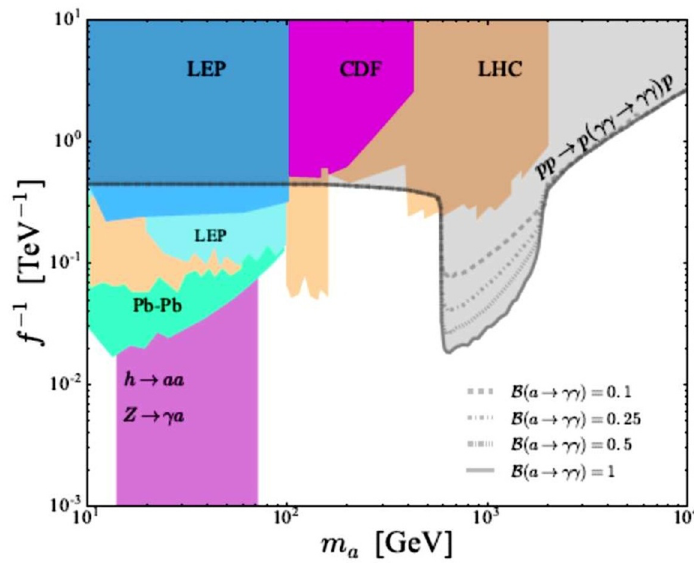
Figure 7 . The 95% C.L. current exclusion regions for different values of Br( a